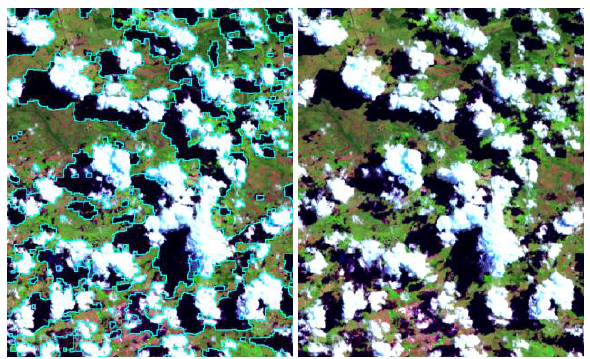
Figure 5 - Output cloud and shadow classification derived from Cloud Detection Tool (left) and Landsat-8 image (right) adopted showing high density of cloud